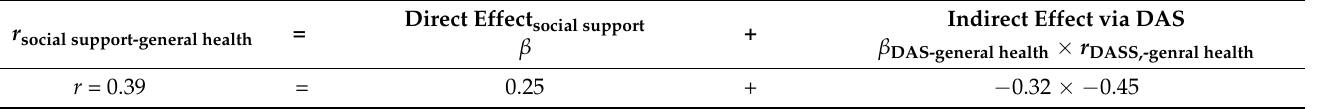
Table 6. Equation model to predict general health. Model